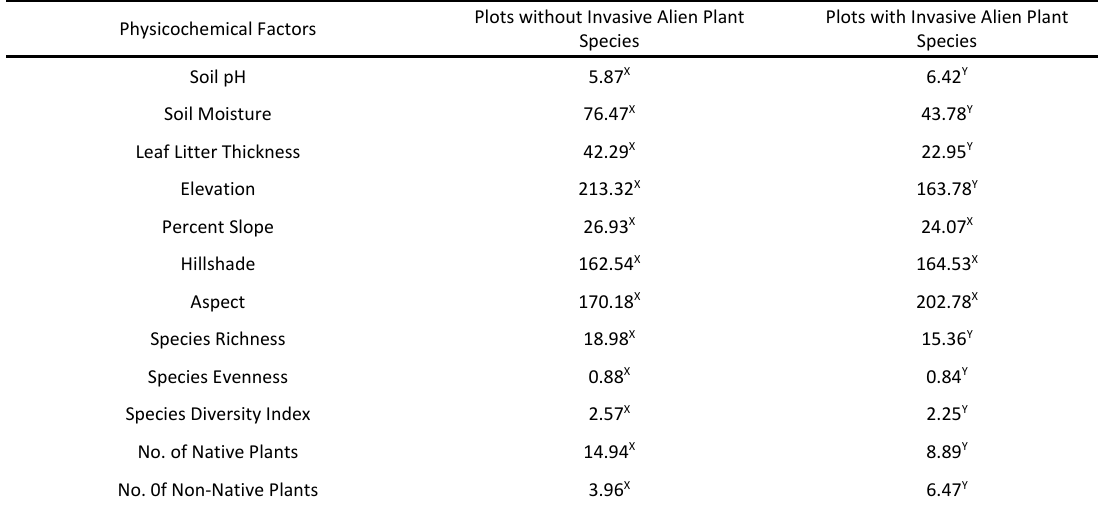
Table 4: Physicochemical factors of plots with and without Table 4 : Physicochemical factors of plots with and without IAS Plots without Invasive Alien Plant Plots with Invasive Alien Plant Physicochemical Factors Species Species